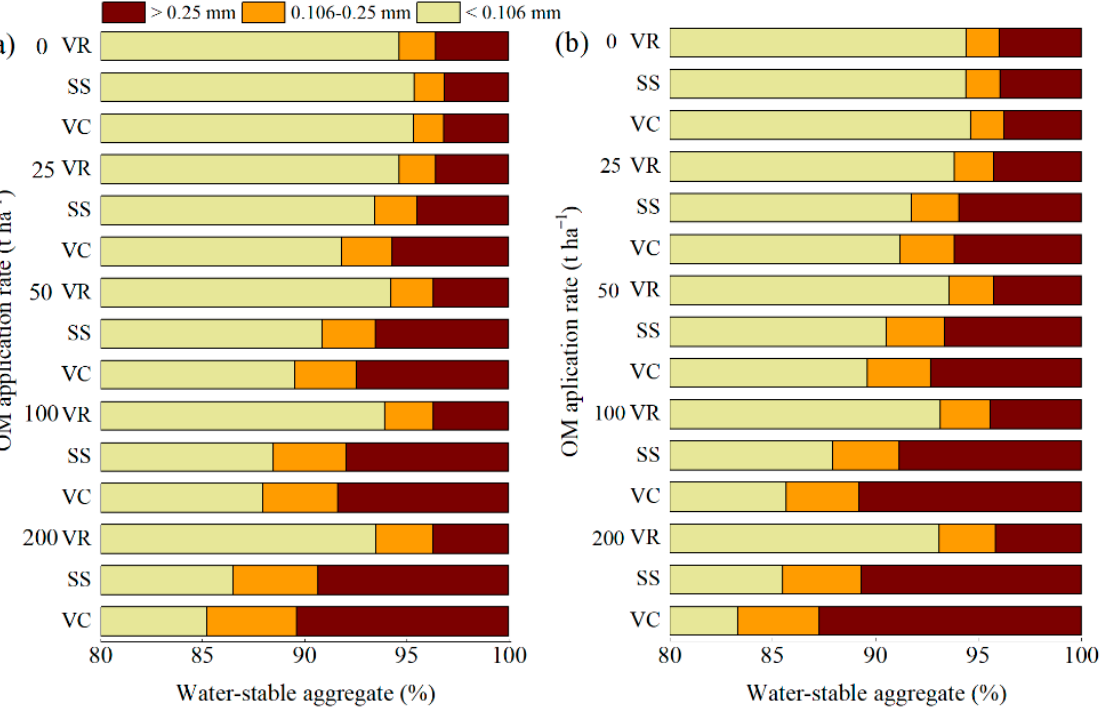
Figure 4. The percentages of soil water-stable aggregate in response to the application of different organic materials in saline-alkali soil: ( a , b ), soil water-stable aggregate in 2020 and 2021, respectively; VR, vinegar residue; SS, sewage sludge; VC, vermicompost; OM, organic material. Table 3. Correlation and path analysis of barley yield and related soil barrier factors and fertility indicators in saline-alkali soil amended by different organic